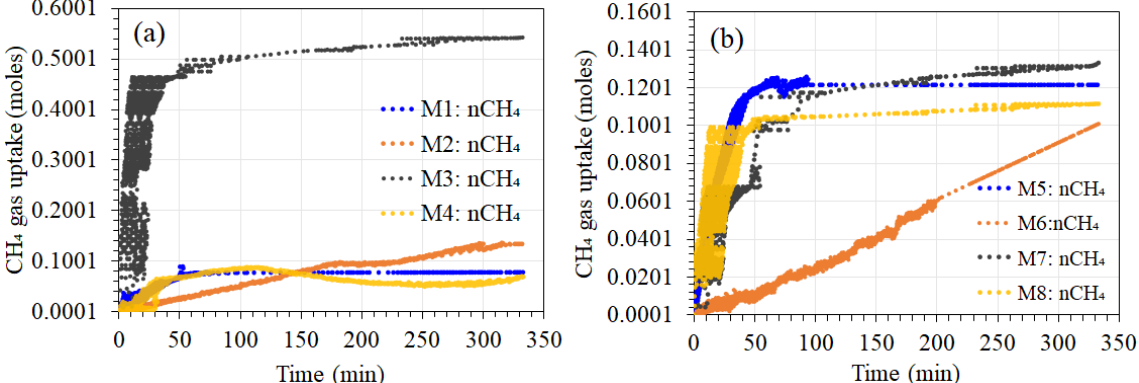
Figure 5. Comparison of CH₄ gas uptake (moles) in two different types of water ( ( a ) DIW; ( b ) Seawater) with and without promoters.